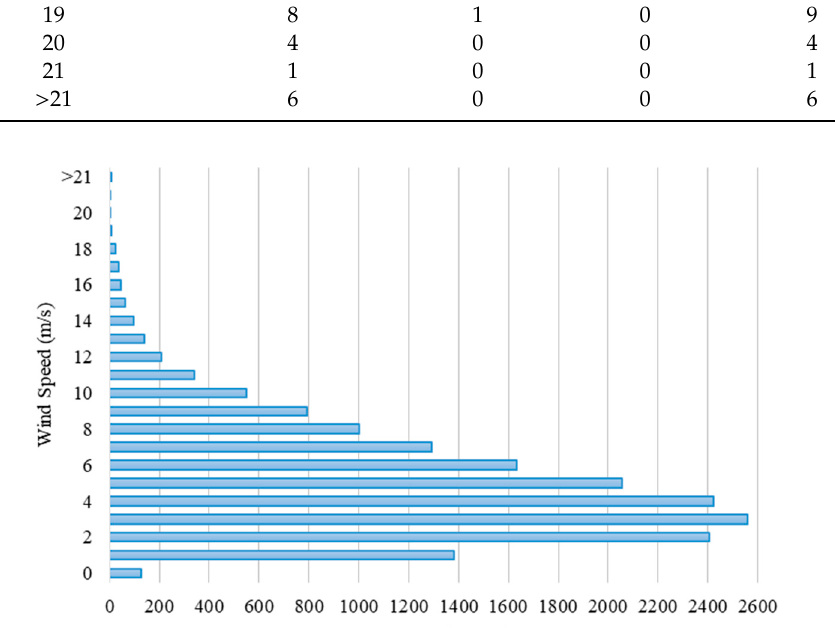
Figure 2. Wind speed recurrence. Table 2. Wind speed distribution.